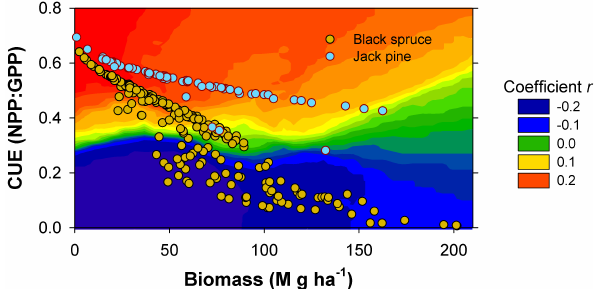
Fig. 7. Relationship between simulated carbon use efficiency (CUE) and aboveground stand biomass. A contour plot of the trends in NPP (as indicated by the strength coefficient r) over 1950–2005 across the two-dimensional space is also